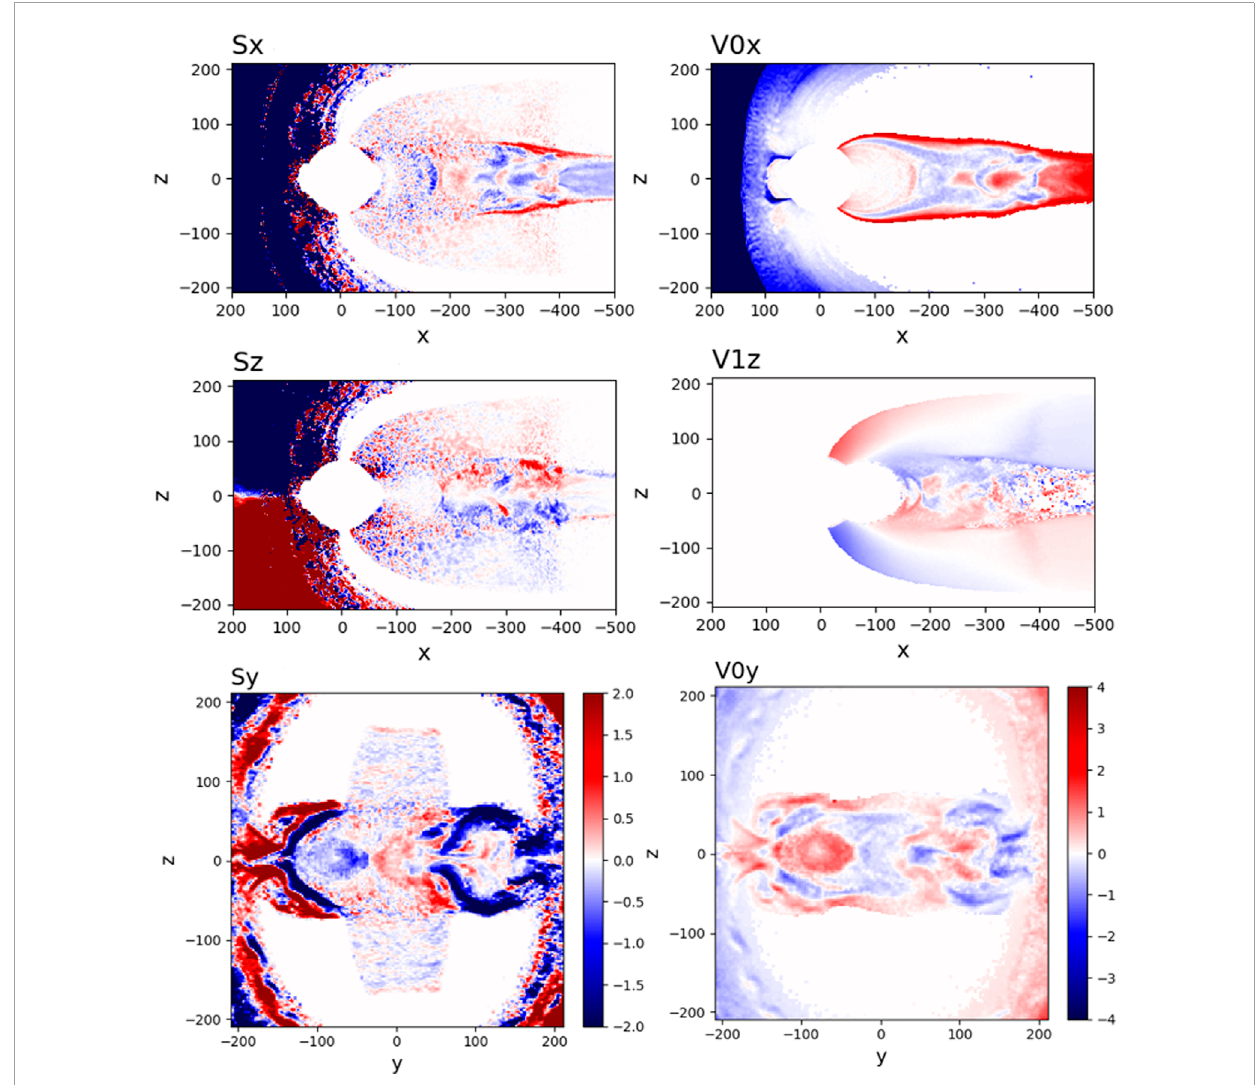
FIGURE 6 Ion velocity ( V 0 stands for H+ and V 1 for O+) and Poynting vector ( S ) components in two cross-sections in the first lobe outflow simulation at Ω cp t = 314: x–z ( y = 1 d i ) and y–z ( x = − 199 d i )